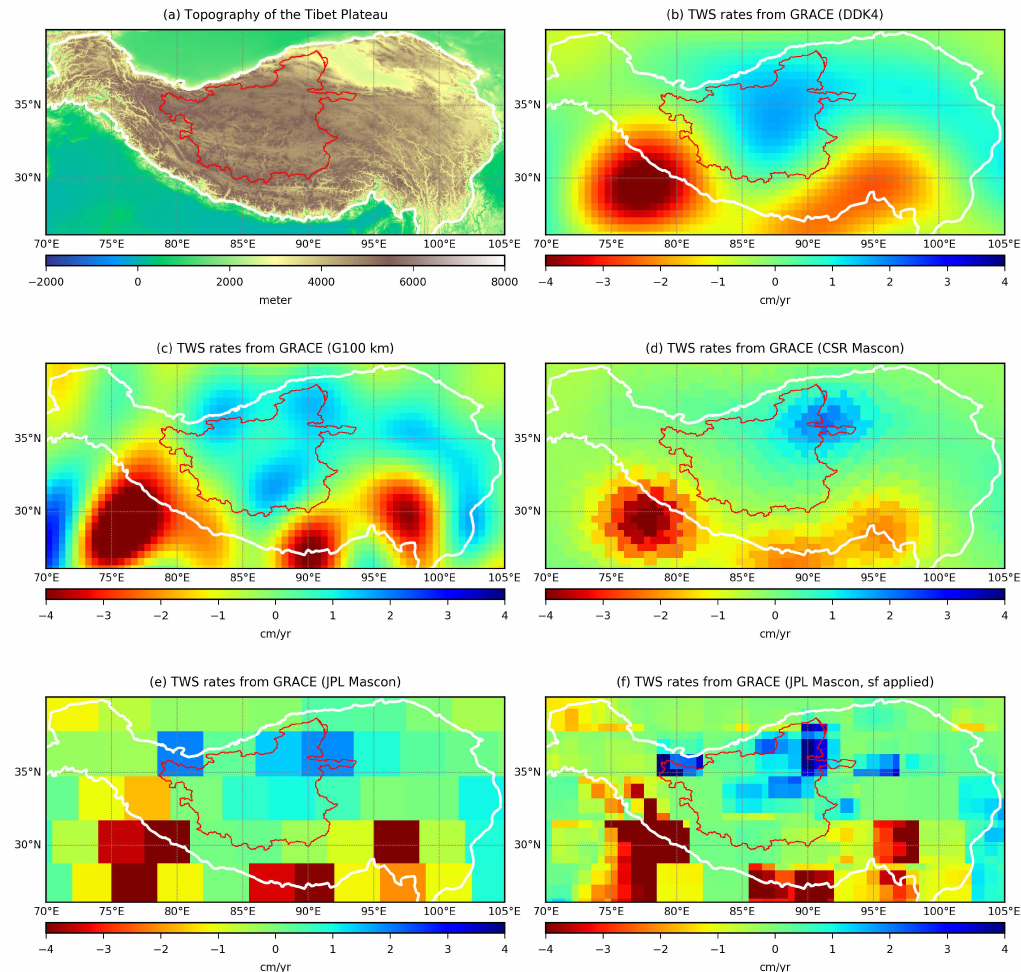
Figure 12. ( a ) Topography of the TP and its surroundings. TWS rates from GRACE during 2002–2014 based on CSR SH products with ( b ) the DDK4 filtering, ( c ) 100-km Gaussian smoothing applied, and based on ( d ) CSR mascon products, ( e ) JPL mascon products, and ( f ) JPL mascon products with gridded scaling factors applied. The white line shows the boundary of TP. The red boundary outlines the Inner